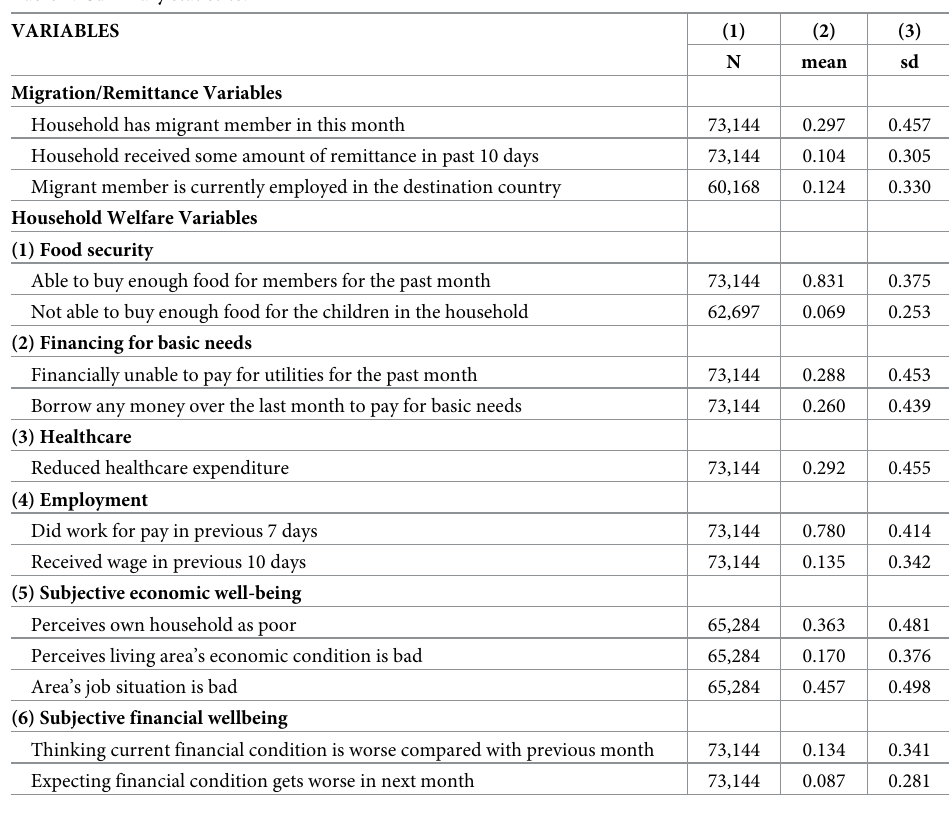
Table 1. Summary